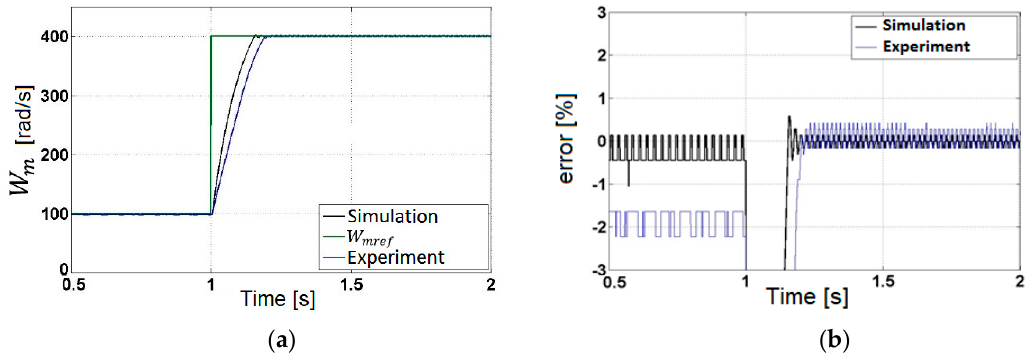
Figure 7. Numerical and experimental results for the system in closed loops: ( a ) mechanical speed 𝑊 (cid:3040) and 𝑊 (cid:3040)(cid:3045)(cid:3032)(cid:3033) in closed loop and ( b ) error of 𝑊 (cid:3040) in closed loop. and W mref in closed loop and ( b ) error of W m in closed loop.